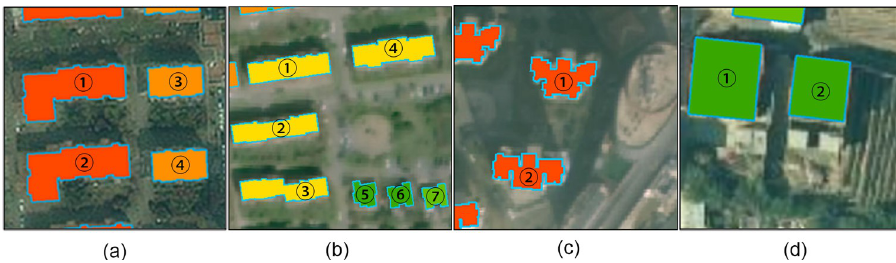
Table 2 summarized the accuracy verification results of POP est and Worldpop datasets. The MRE and %RMSE of Worldpop dataset were 44.02 and 67.17%, respectively. while the MRE (33.6) and %RMSE (43.65%) of POP est predicted by this method were significantly decreased, which was significantly lower than that of Worldpop dataset. Meanwhile, R 2 ranges from 0 to 1, and the closer it is to 1, the stronger the correlation is. Therefore, it can be concluded that tion distribution.